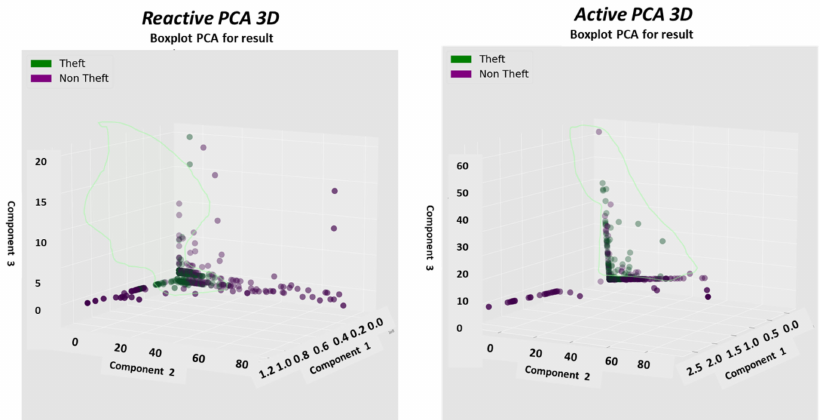
Figure 15. Reactive vs. active 3D PCA of seasonal-hourly boxplot trends—clustered are the non- frauds. First filtration: fraud—technical/nontechnical. Non-fraud—other anomalies, blue cluster. Here, fraud is actual fraud. Differentiation between technical loss types is similar. Soft green transparent reinforces the theft